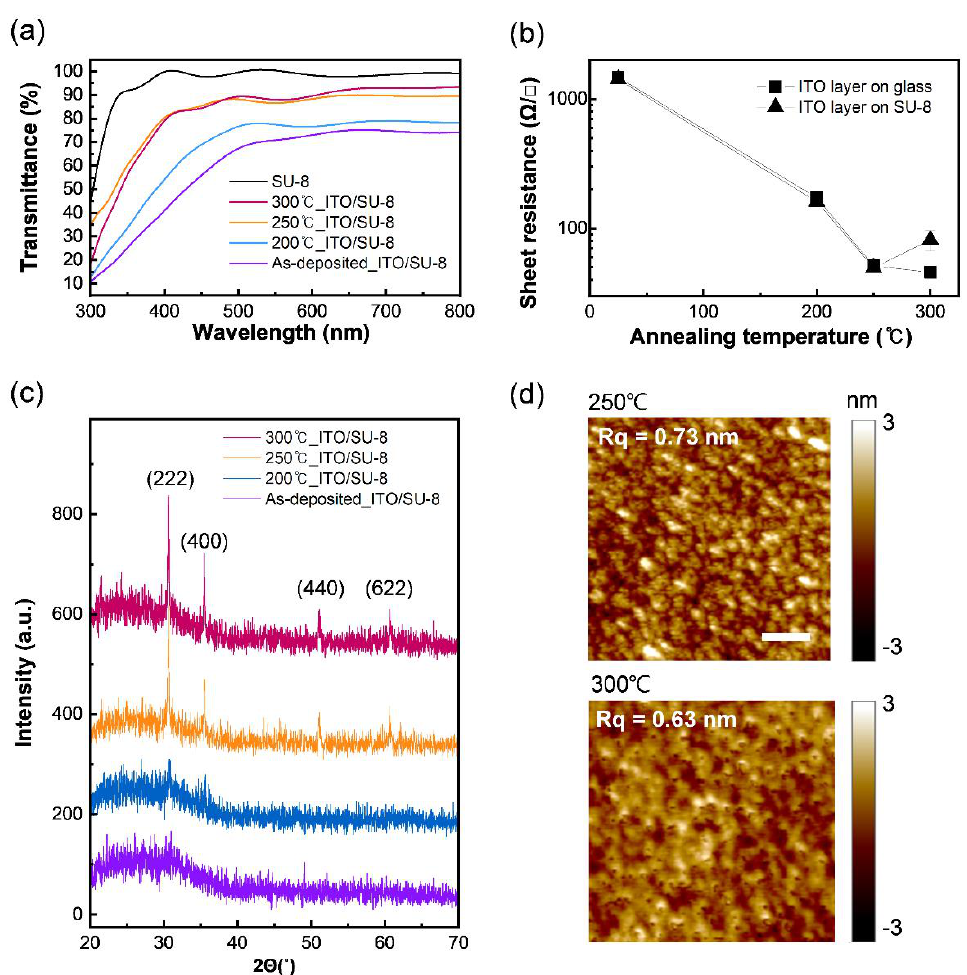
Figure 2. Optical and electrical characteristics of the ITO/SU-8 layers for the vibration sensor. ( a ) Transmittance of the ITO/SU-8 layer within a UV-visible wavelength range (300 – 800 nm) depending on the temperature of the post-thermal annealing. Black line represents an SU-8 layer without ITO electrode. ( b ) Conductivity of ITO electrode on glass and SU-8 layer depending on thermal annealing. ( c ) X-ray diffraction image of ITO/SU-8 layer depending on the temperature of post-thermal annealing. ( d ) Surface morphology of ITO/SU-8 layer after thermal annealing at 250 °C (Top) and 300 °C (Bottom) (scale bar, 100 nm).